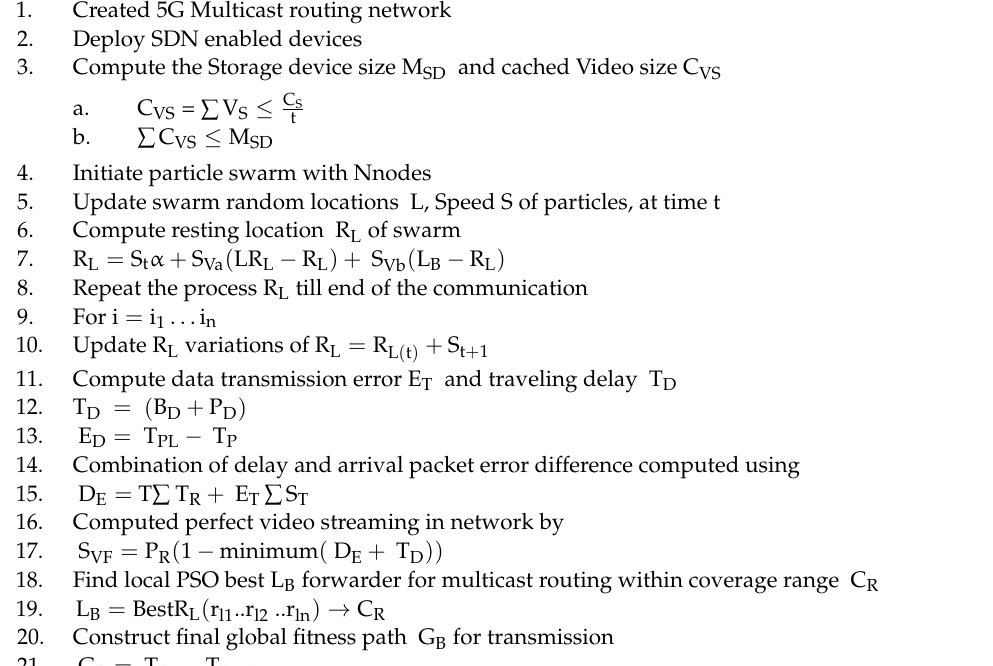
Algorithm 1 Optimal Video Streaming